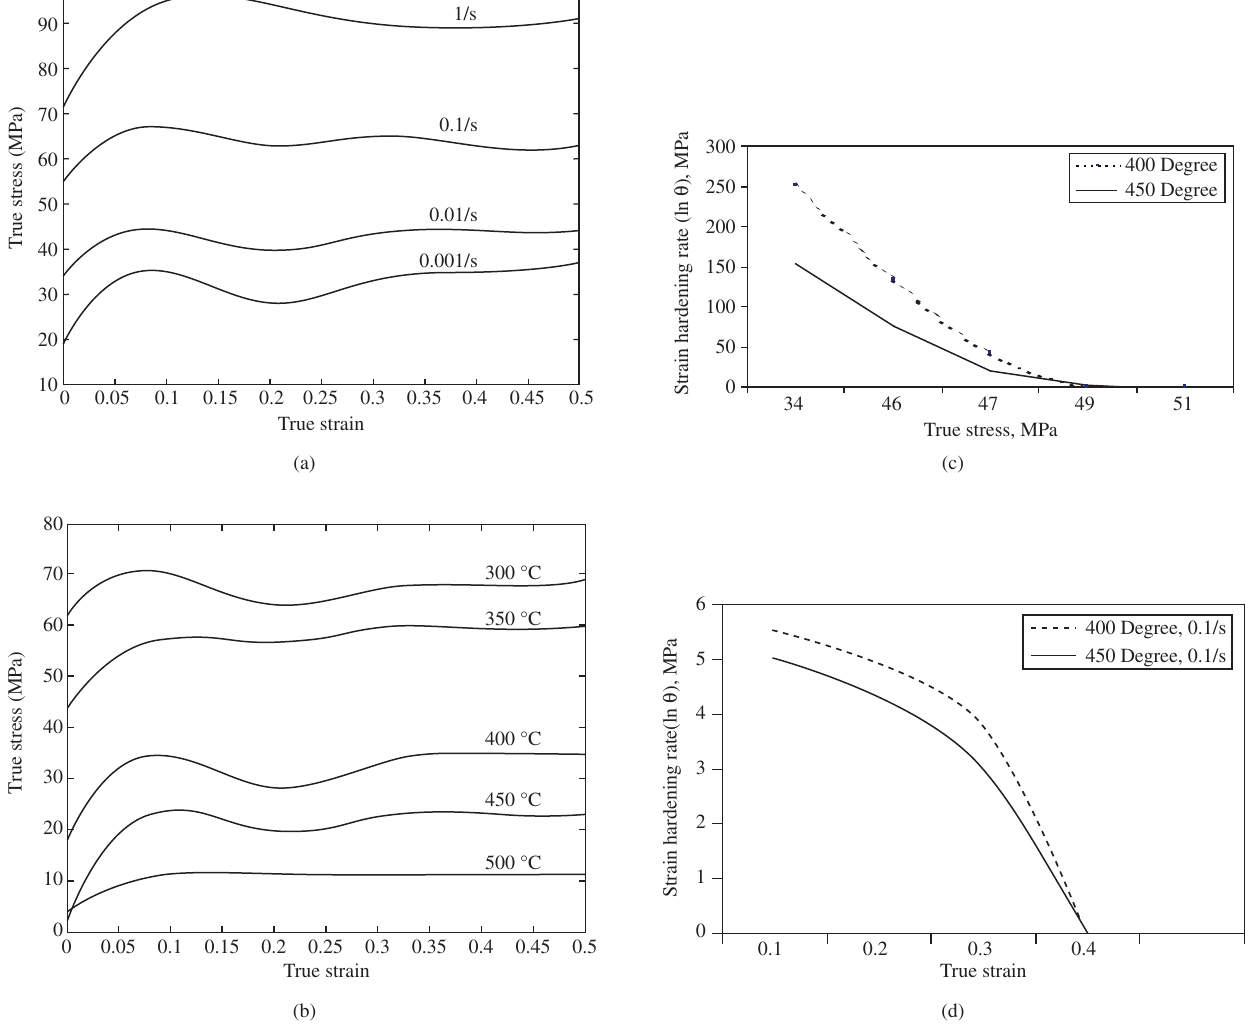
Figure 1. Flow curves of Mg composite for different: a) Strain rates at a constant temperature of 400 °C; and b) Temperature and at constant strain rates 0.001 s -1 . Strain hardening rate plots for Mg/4.5%Ti composites, effect of temperature on: c) Strain hardening rate; and d) critical strain at the onset of DRX.